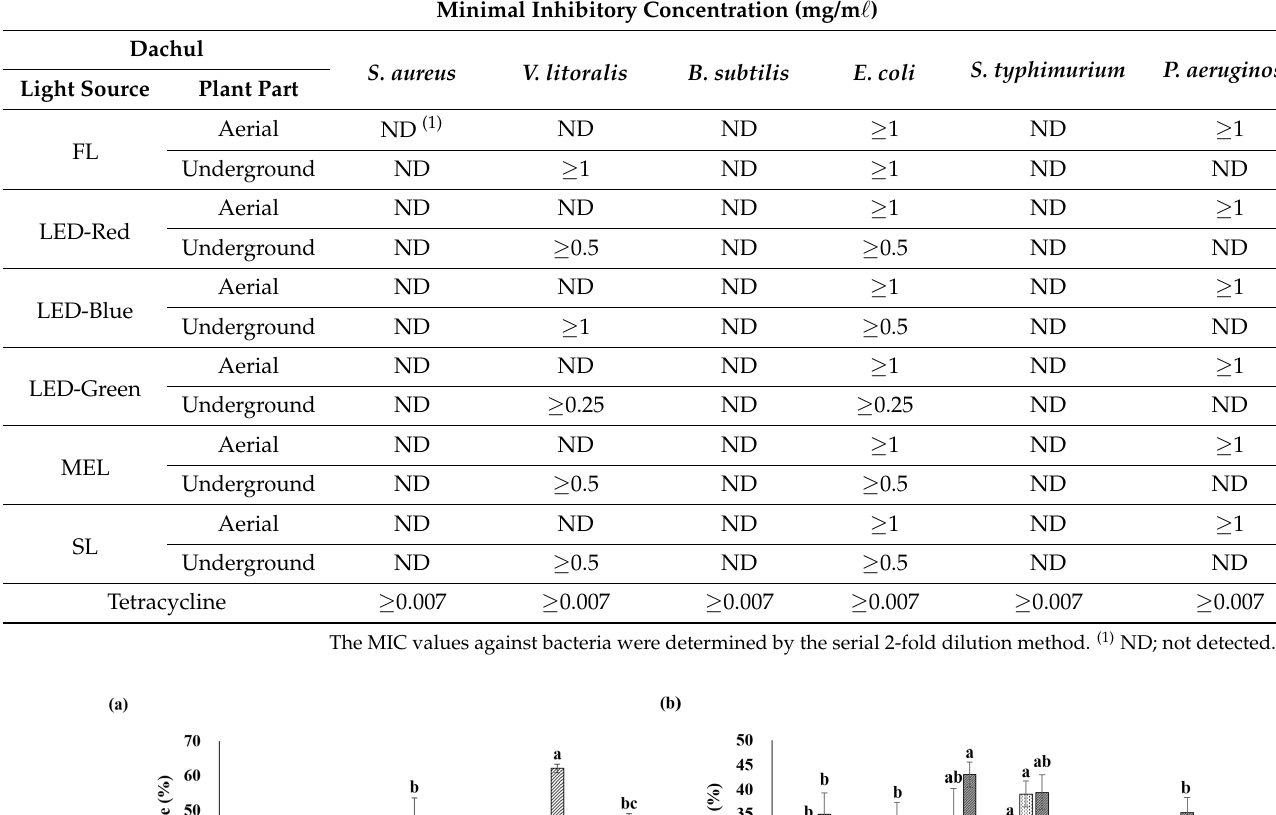
Table 2. Antimicrobial activity by parts of aerial and underground from extracts of Dachul treated with artificial light sources for 2 weeks.